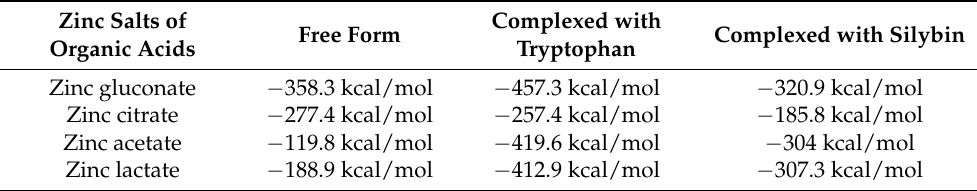
Table 2. Molecular mechanics computed energy E of free forms of zinc salts of organic acids and when forming complexes with the amino acid tryptophan and the flavonoid